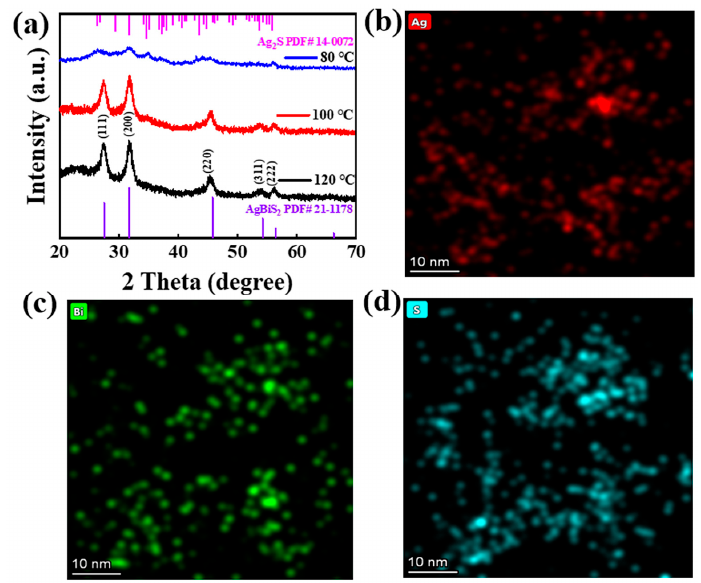
Figure 4. ( a ) XRD patterns of OLA–S–based colloidal AgBiS 2 NCs synthesized at 80 °C, 100 °C, and 120 °C; ( b – d ) EDS elemental mapping (TEM) images of OLA–S–based colloidal AgBiS 2 NCs prepared at 120 °C.